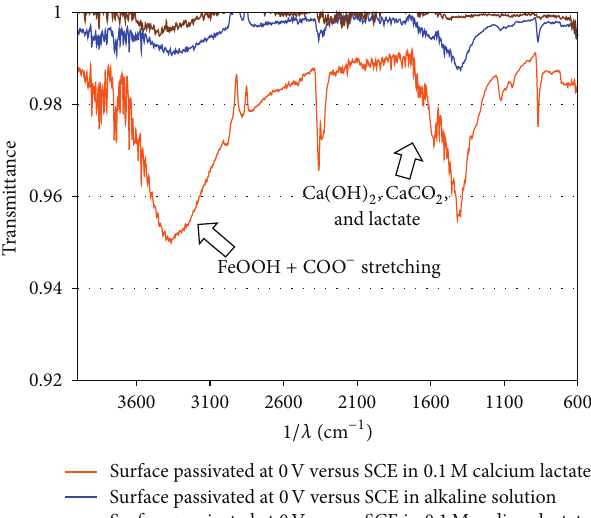
Figure 13: FTIR spectra of a specimen passivated in solution with and without calcium lactate 0.1 M or sodium lactate 0.1 M at pH 13.5 and 0V versus SCE.